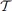
Market profit, financial symmetry and market temperature.The figure illustrates the “Market Profit” of MP expansion as a function of order parameter for two different “temperatures” corresponding to T ≥ Tc (solid blue line), and two T < Tc (dashed green line), respectively.